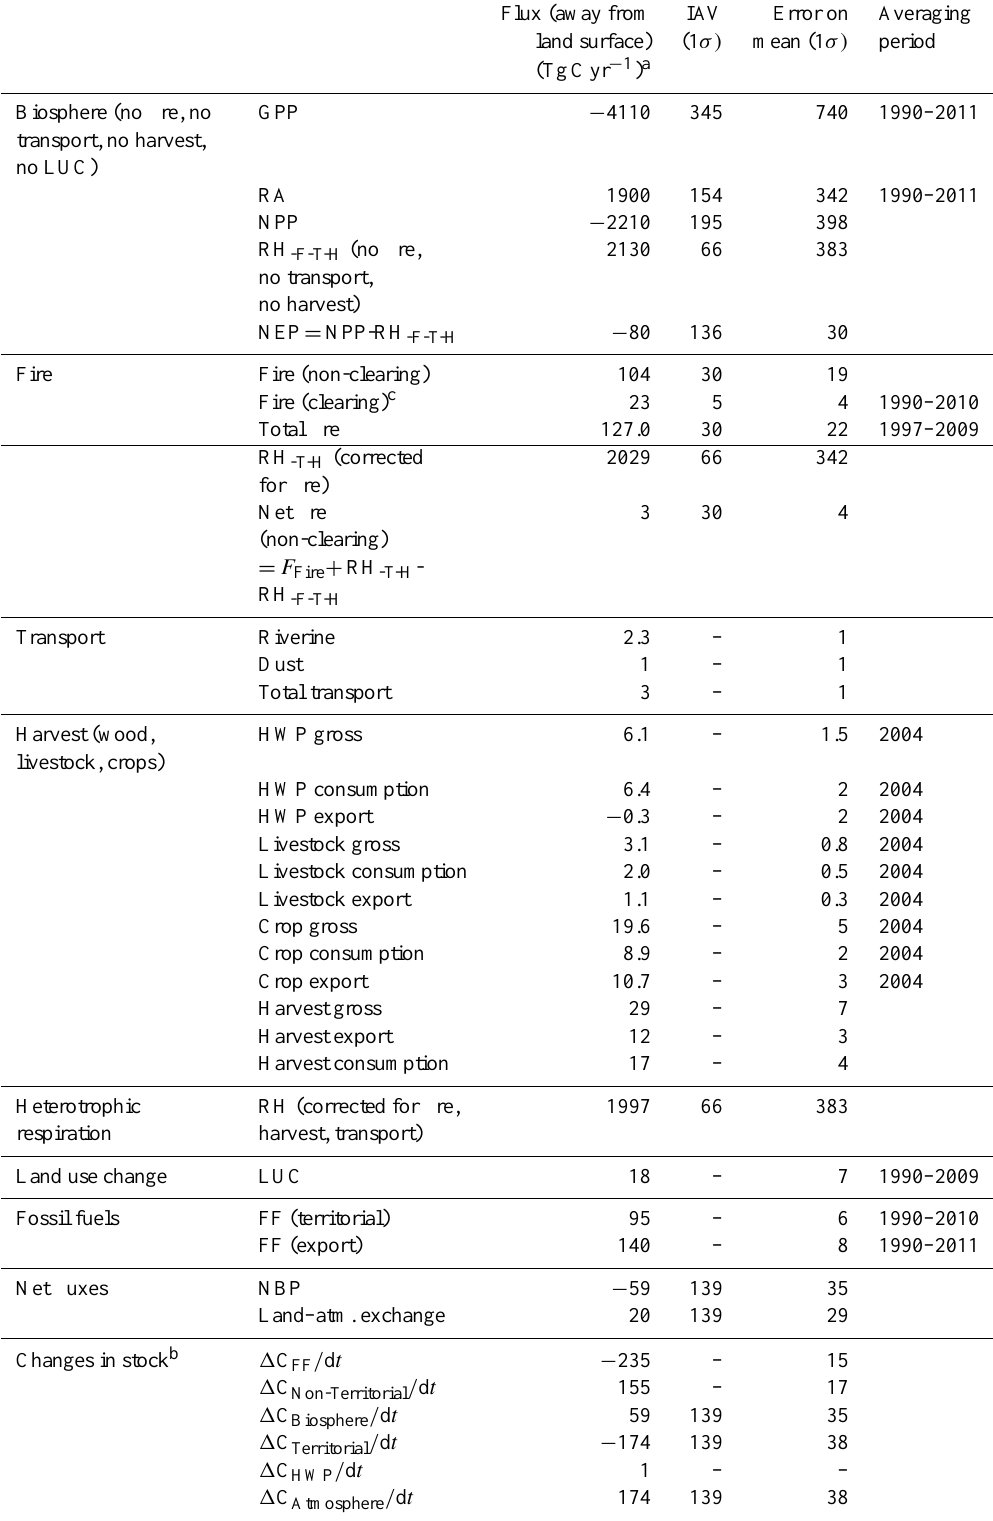
Table 1. Components of the Australian Territorial Carbon